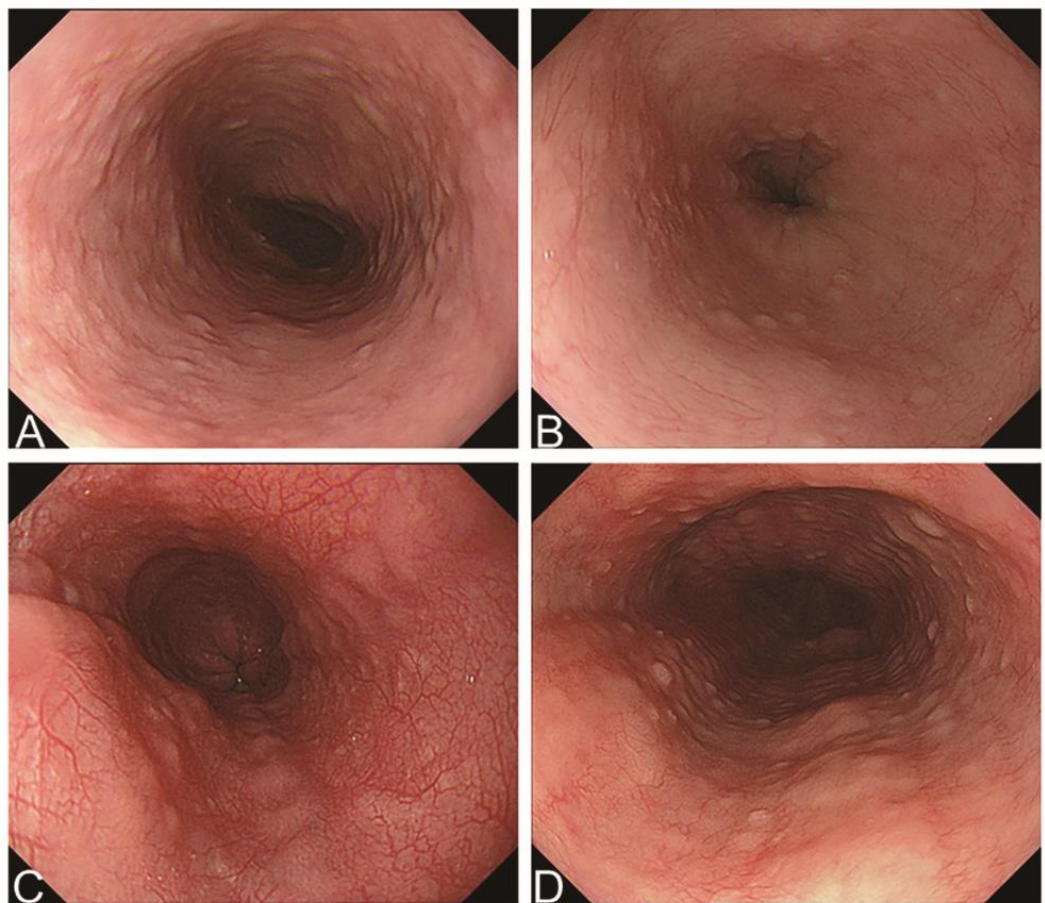
Figure 4. Sample false-positive and false-negative images. ( A , B ) Misdiagnosis of normal structures. ( C ) Ankylosaurus back sign. ( D ) Obscure findings related to linear furrows.